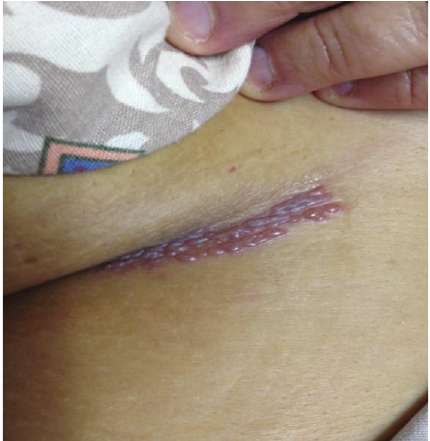
Figure1:Theskininvolvementcharacterizedthroughvesicularrash extending over the dermatome